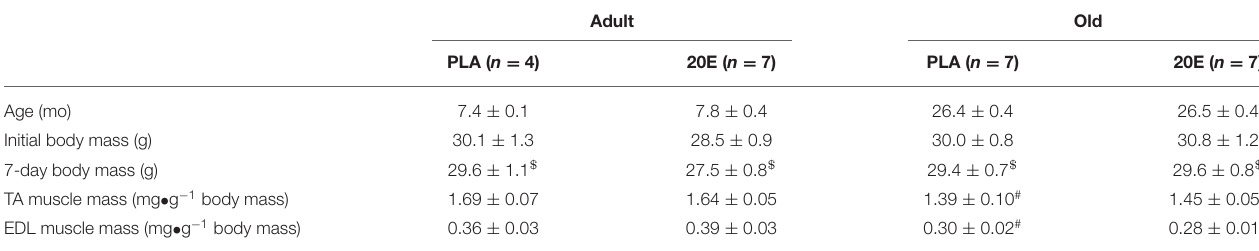
TABLE 1 | Animal and muscle characteristics of eccentric damage